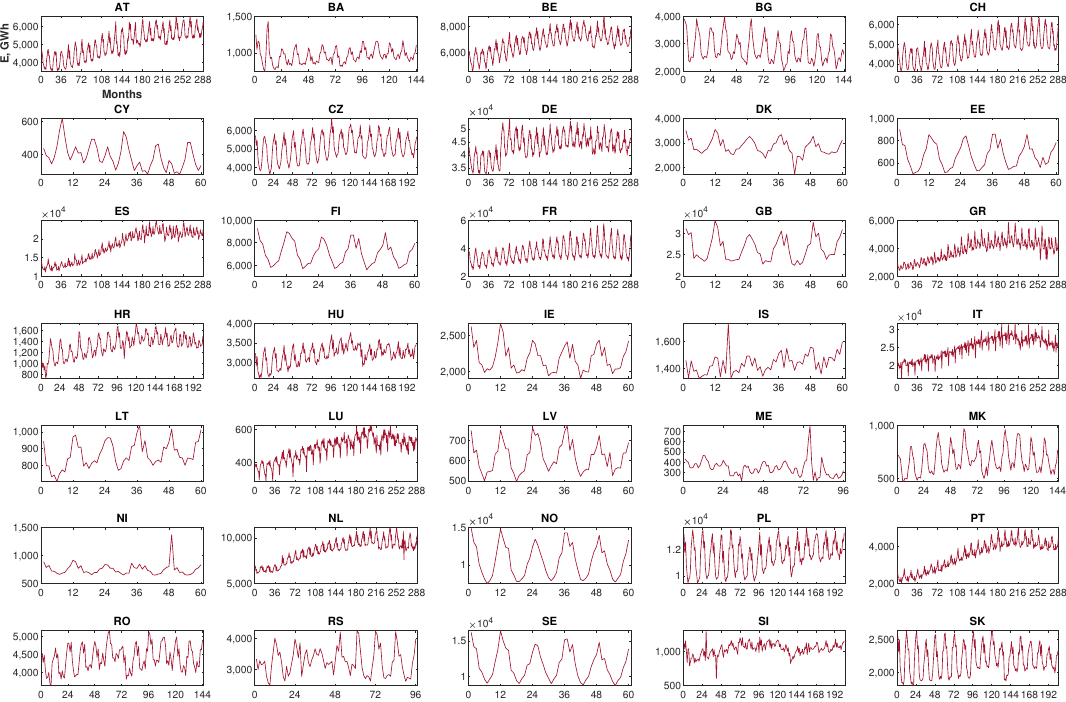
Figure 2. Monthly electricity demand time series for European countries. Relationship between observations of the time series distant by l time units are assessed using the autocorrelation function (ACF) and the partial autocorrelation (PACF). The